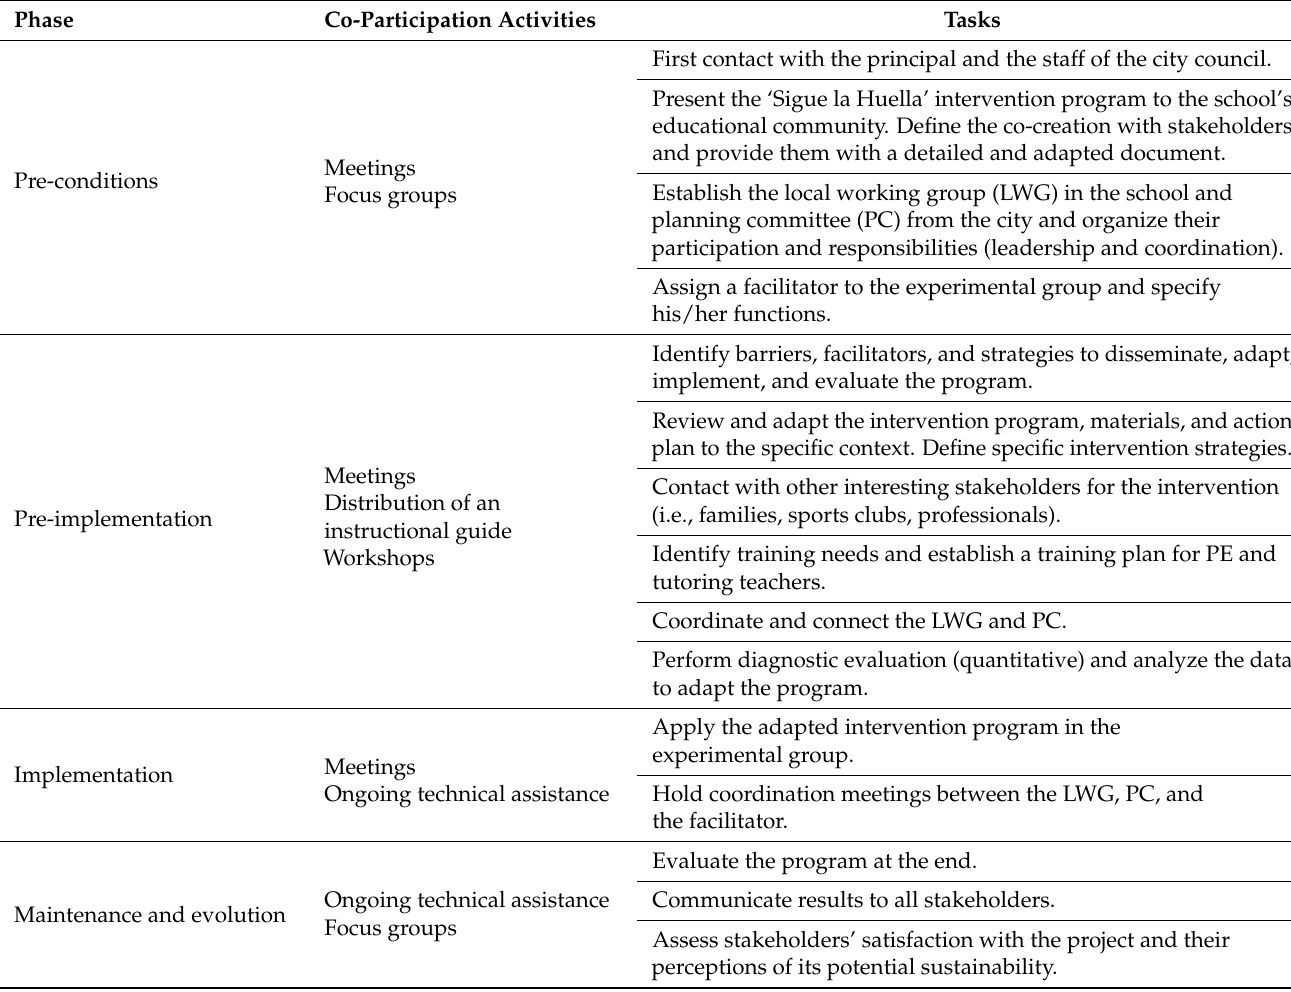
Table 1. Replicating effective programs: phases, co-participation activities, and